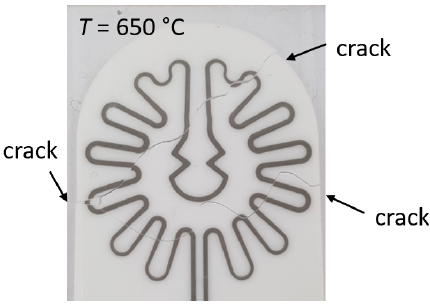
Figure 6. Magnified view of the heating meander on the bottom side of the sample holder. The substrate cracked at a temperature of about 650 ◦